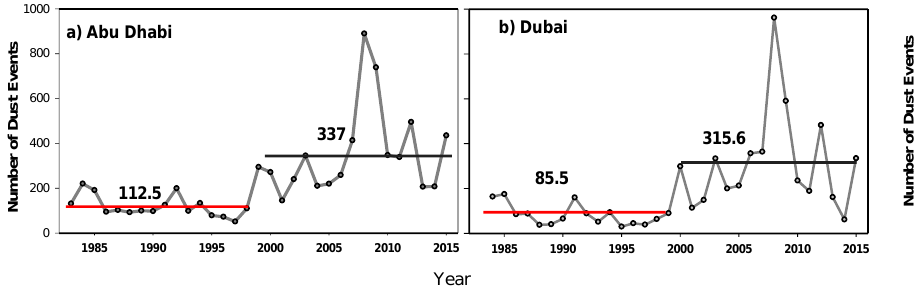
Figure 12. A homogeneity analysis for number of dust events in ( a ) Abu Dhabi and ( b ) Dubai cities.